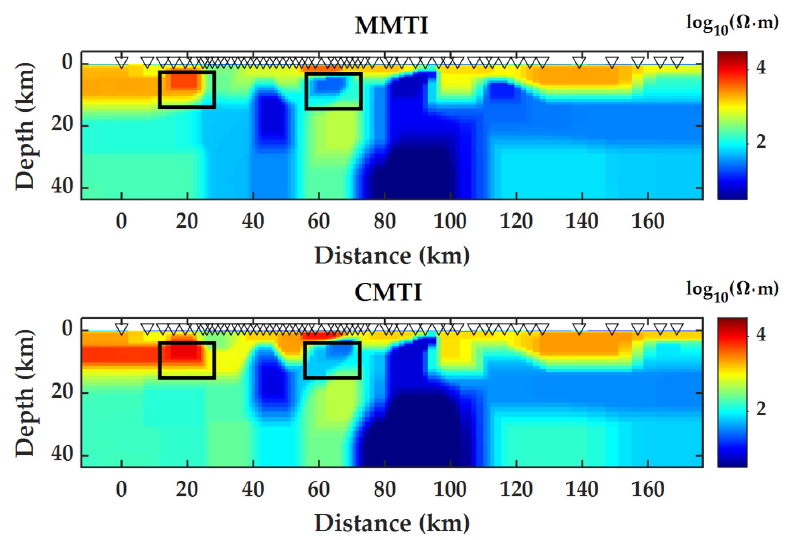
Figure 10. Comparison of inversion for field data (the top is the result of MMTI, the bottom is the result of the CMTI).